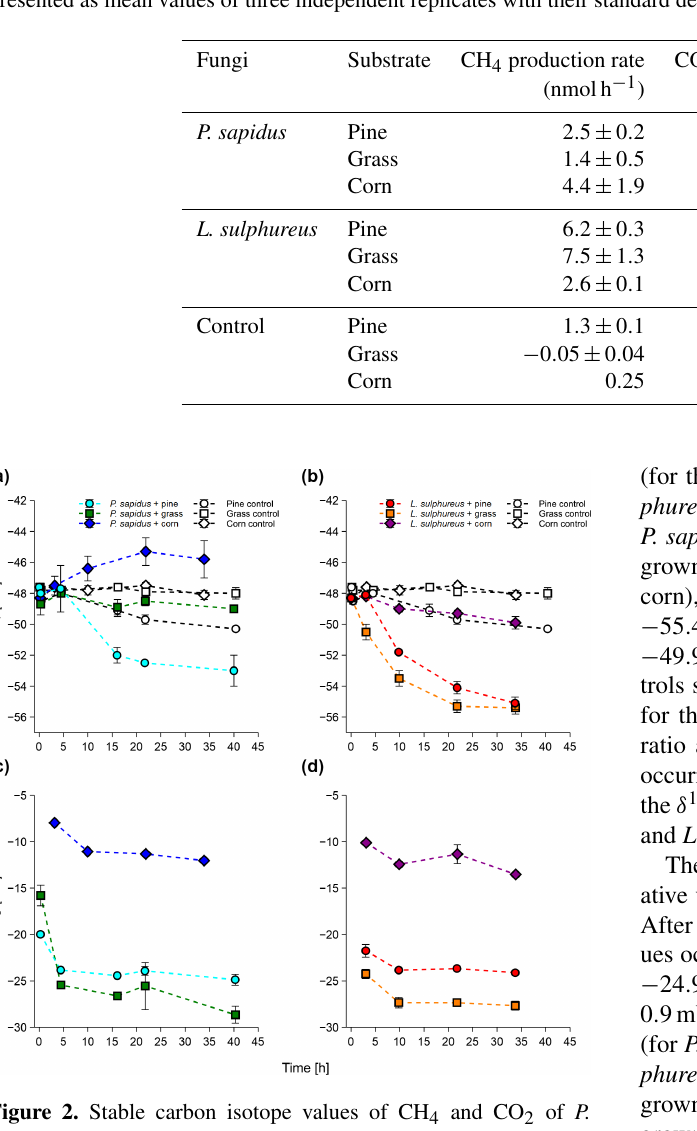
Table 1. CH 4 and CO 2 production rates and molar CH 4 : CO 2 emission ratios of the fungi incubated on different substrates. Values are presented as mean values of three independent replicates with their standard deviation ( n = 3), except for the control “corn” ( n = 2).